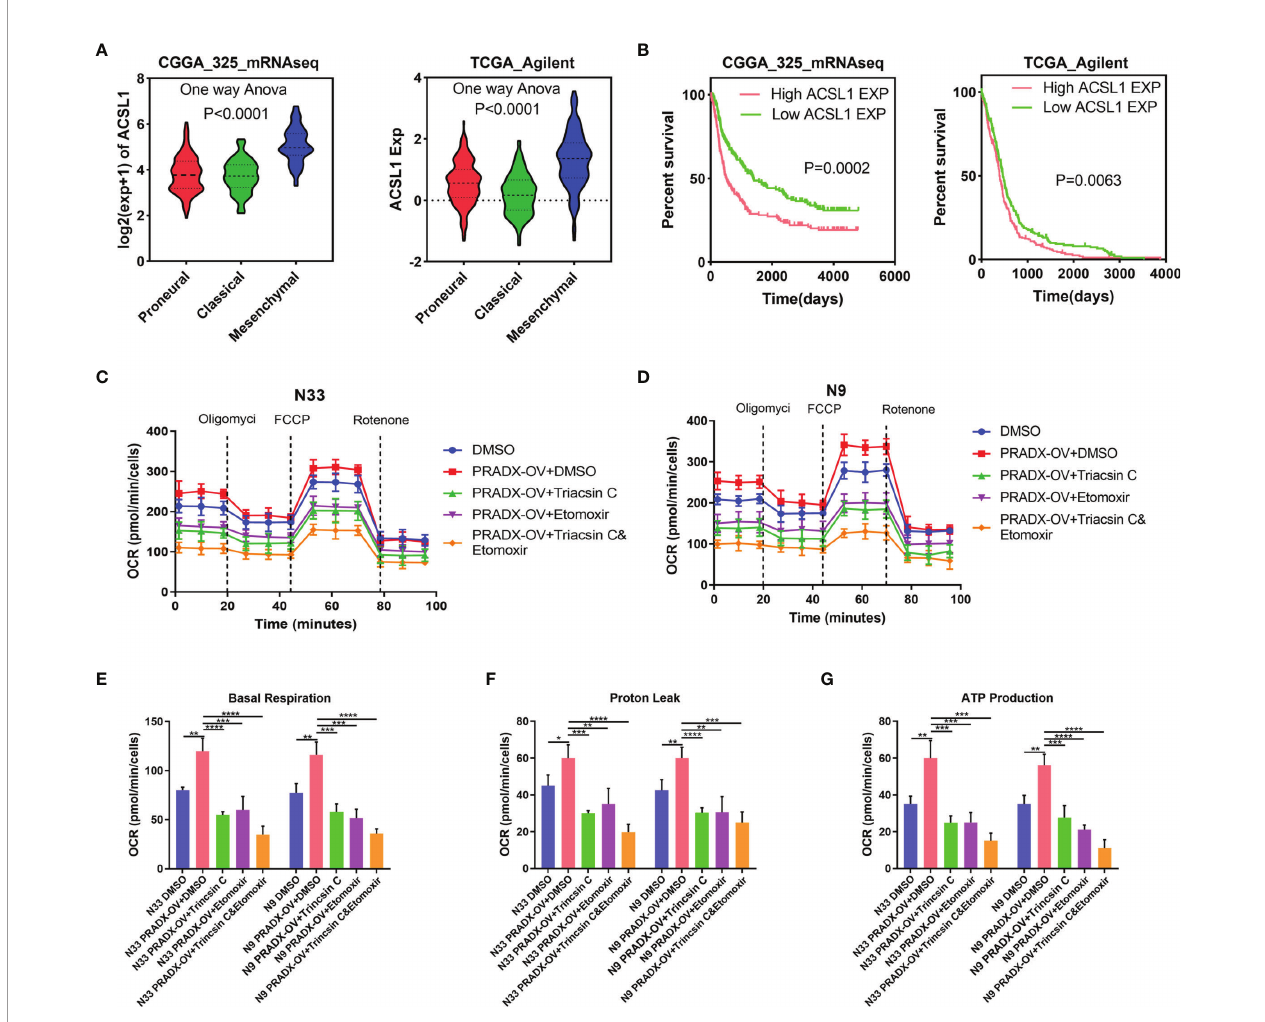
FIGURE 6 | PRADX enhances energy metabolism via increasing ACSL1 in glioma. (A) Violin plots showing ACSL1 expression in different molecular subtypes of GBM in TCGA and CGGA databases. (B) Kaplan-Meier curve showing patients ’ survival times between ACSL1 high expression and low expression groups. (C, D) The time series for the oxygen consumption rate (OCR) was measured by a seahorse analyzer in the indicated groups. (E – G) OCR measurement of basal respiration, proton leak, and ATP production for these fi ve groups above. The values in (C – G) are represented as mean ± SD (n = 3). *P <0.05, **P < 0.01, ***P < 0.001, ****P